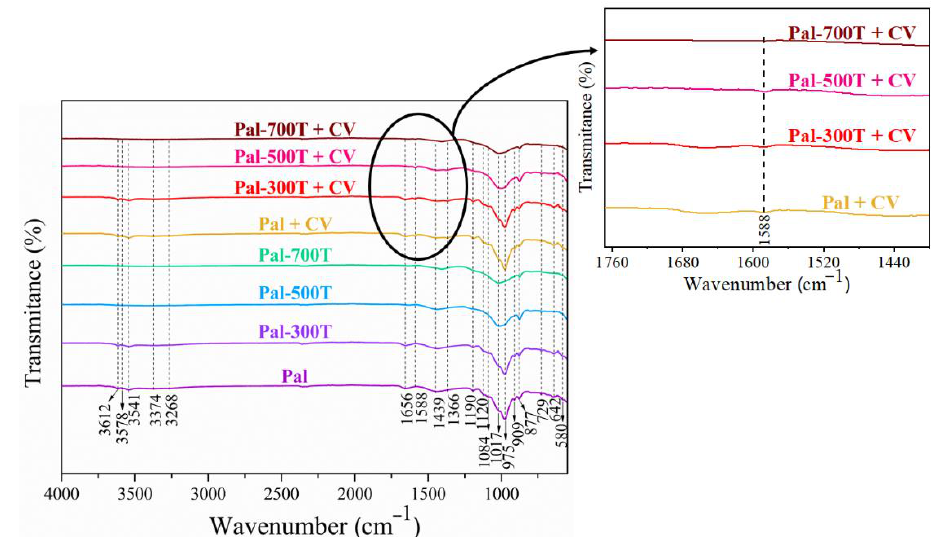
Figure 11. FTIR spectra of samples before and after CV adsorption.